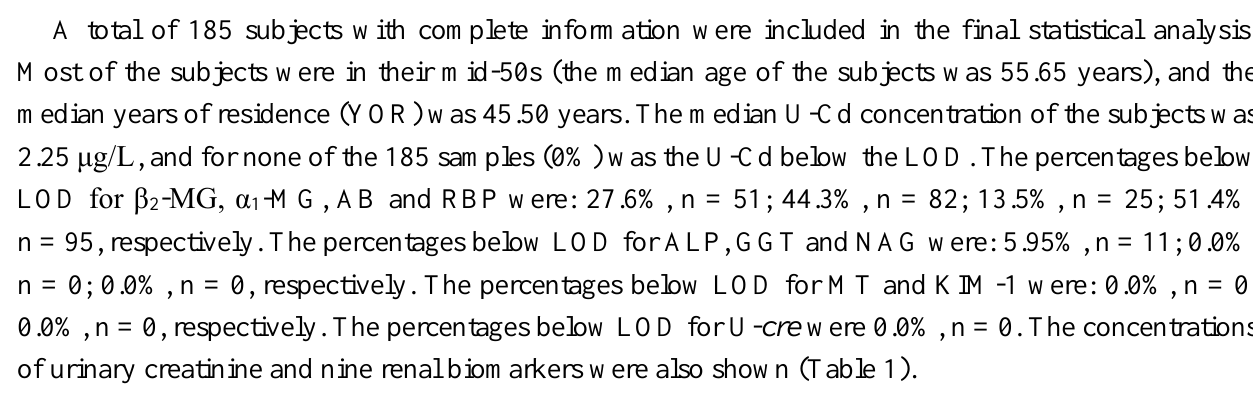
Table 1. Characteristics of the study participants (n =